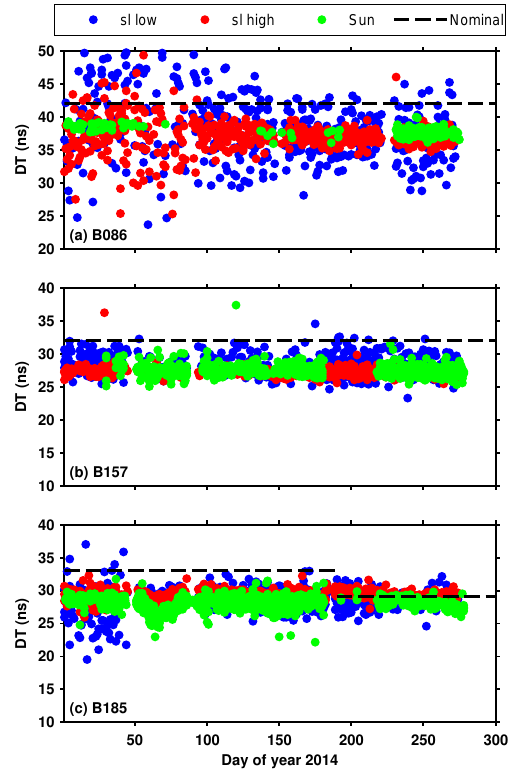
Figure 4. DT calculated from measurements of the standard lamp (high and low intensity) and the Sun as a function of day of year 2014 for three Brewers: (a) B086, (b) B157 and (c) B185. Dashed lines represent the DT used by the instruments in each